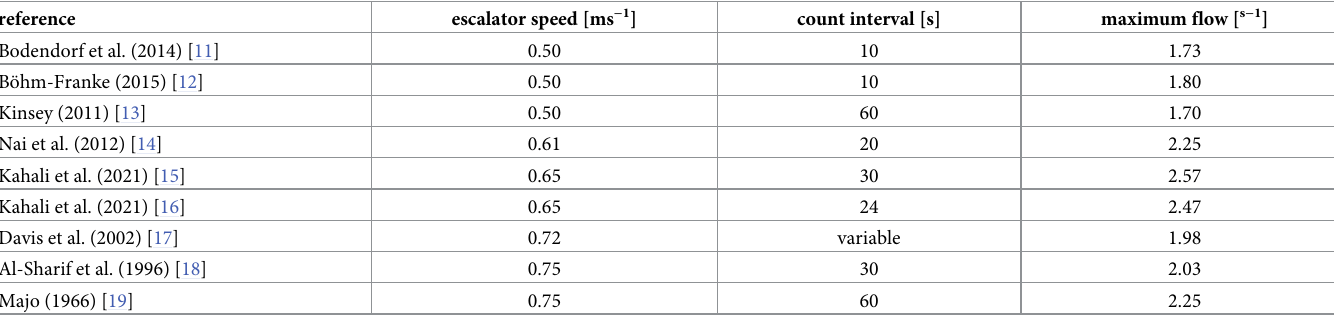
Table 1. References for maximum observed upward flows at